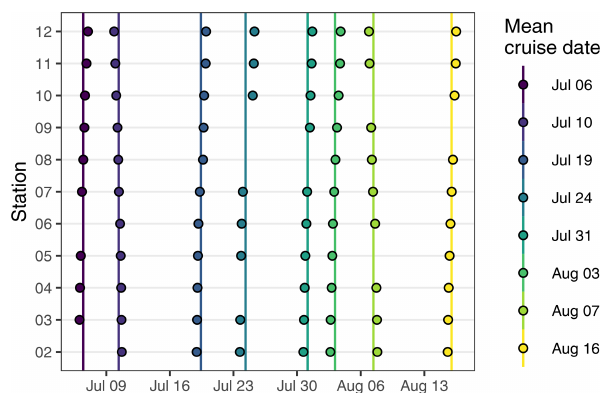
Figure 2. Overview on profiling sensor measurements performed at stations 02–12 (Fig. 1). Individual sampling events are displayed as points, whereas vertical lines indicate the mean date of each cruise